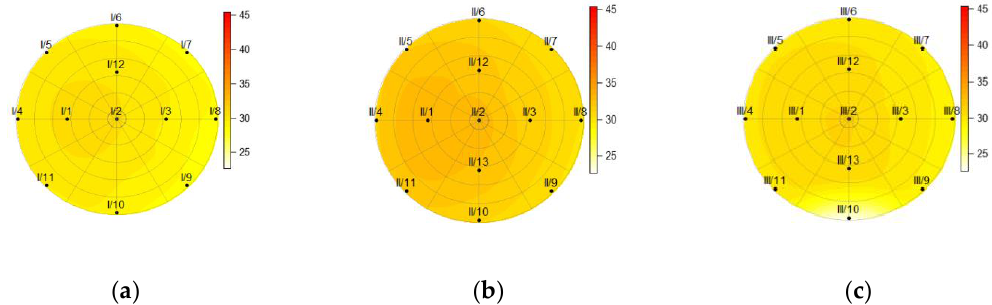
Figure 12. The temperature within the pillar, at a height of ( a ) 150 mm; ( b ) 750 mm; ( c ) and 1350 mm, 5.7 h after the heat source was turned on (before it was turned off).